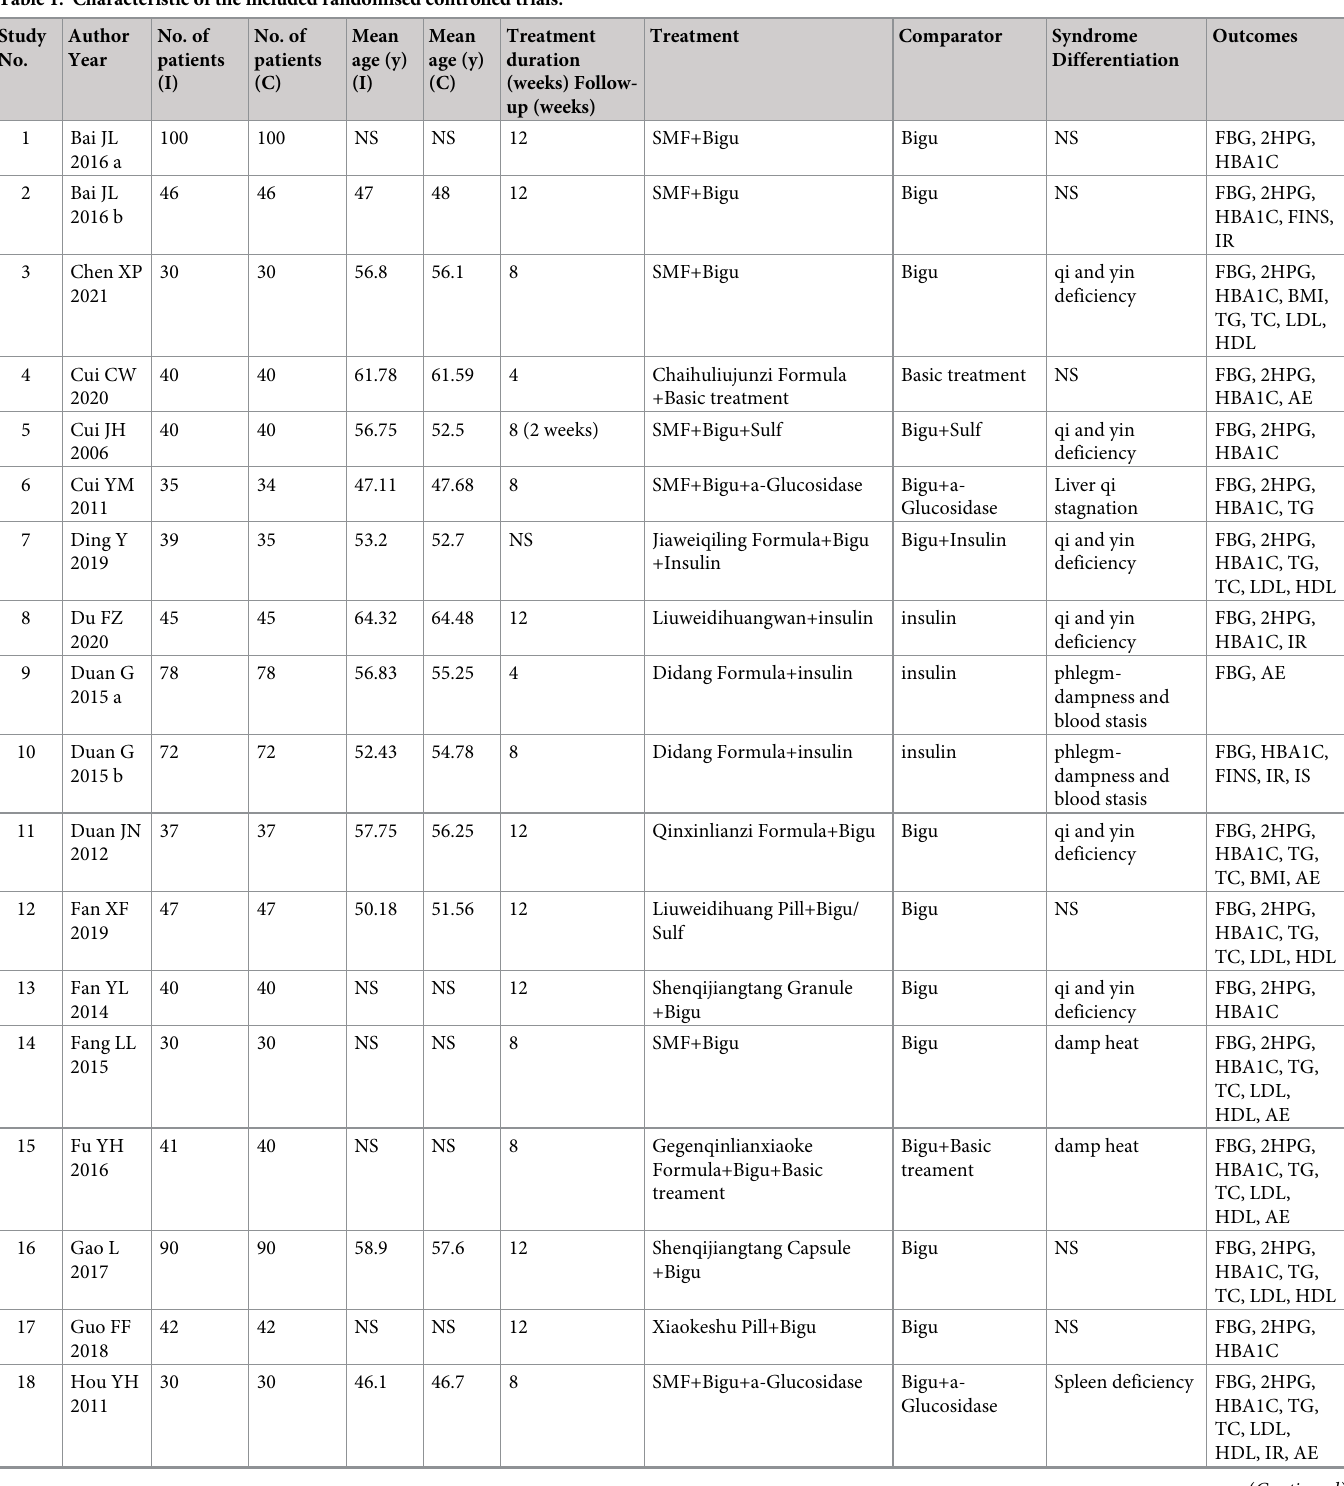
Table 1. Characteristic of the included randomised controlled trials. Study